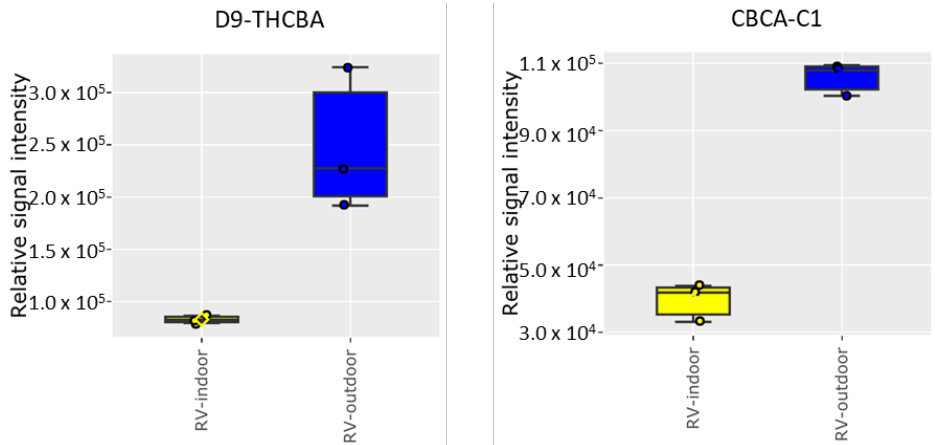
Figure 4. Unusual cannabinoids detected in more abundance in RV-outdoor compared to RV-indoor using LC-MS analysis (n = 3 independent samples per group).